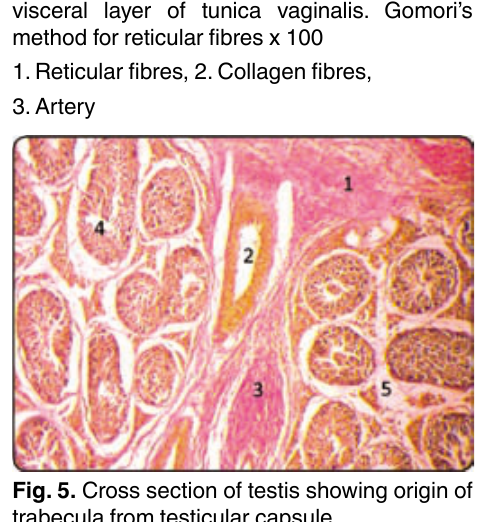
Fig. 5. Cross section of testis showing origin of trabecula from testicular capsule.